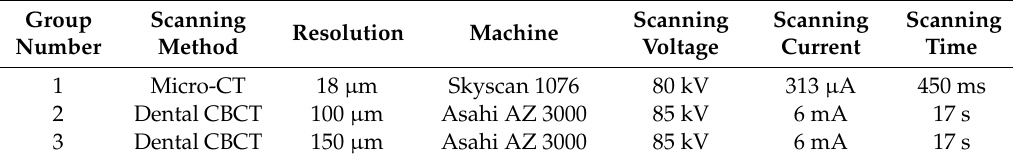
Table 1. Scanning modes and parameters of micro-computed tomography (micro-CT) and dental cone-beam computed tomography